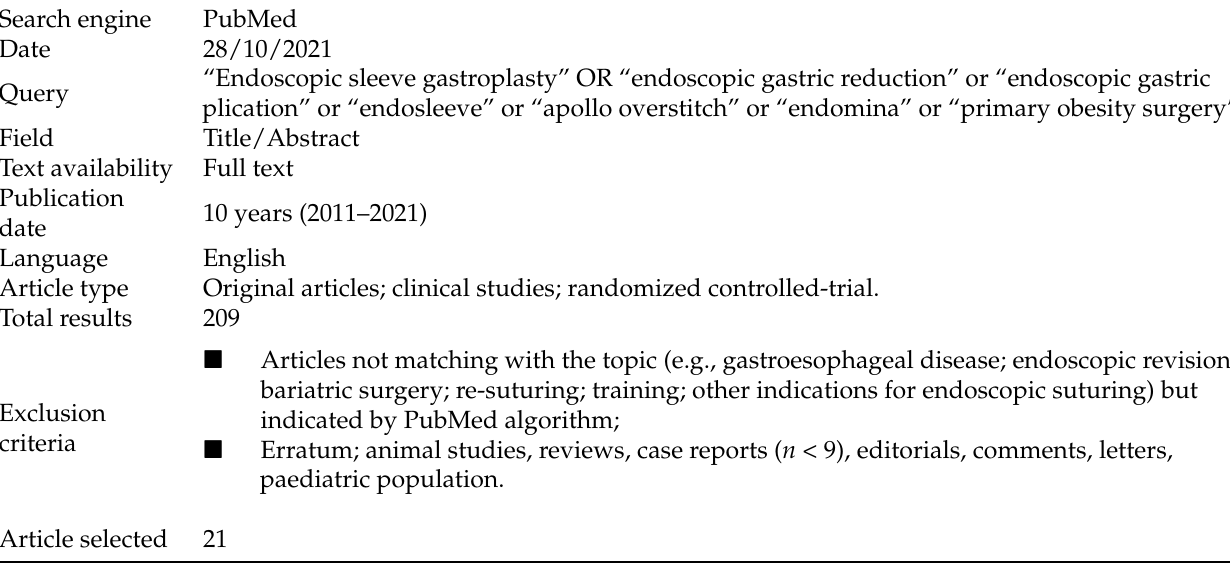
Table 1. Research